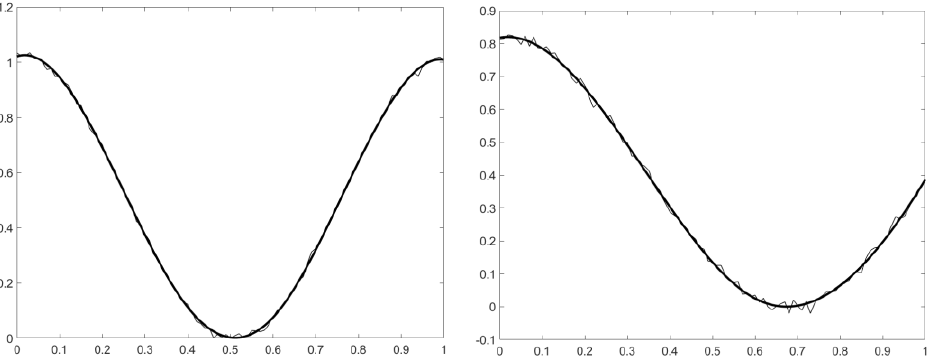
Figure A1. Examples cubic spline fits (thicker lines) to the MC data (thinner lines) for the Sine Wave dataset: ( left ) single trajectory for group 1; ( right ) single trajectory for group 2. Good model fits from the cubic splines are found in all cases.